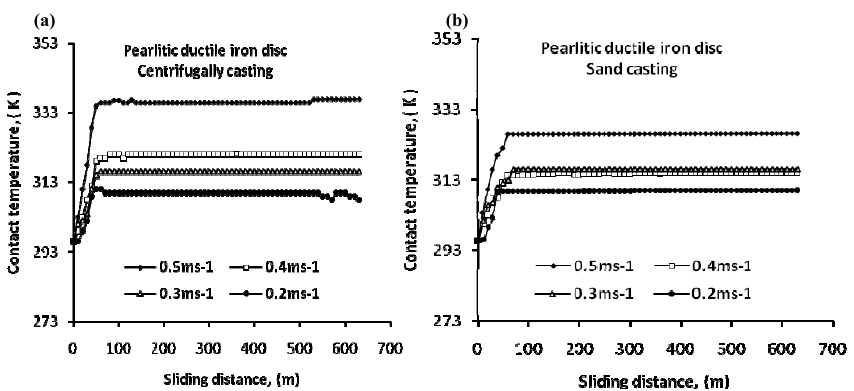
Figure 8. Evolution of the contact temperature ( T in K ) with sliding distance in different liner sliding speed for 40 N applied load.